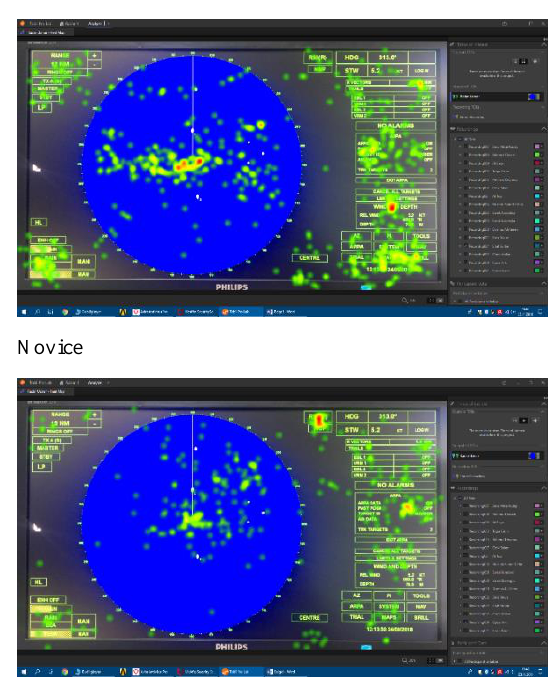
Figure 9. Comparison of sample novice and expert visual heat map data on use of